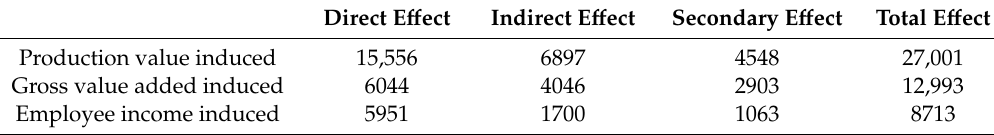
Table 5. The economic impact of constructing a concrete check dam (unit is thousand yen).